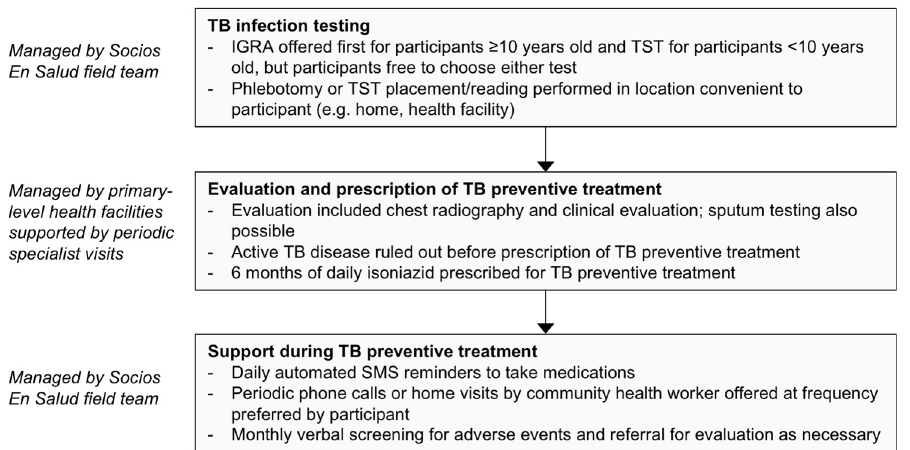
Fig 1. Key procedures for intervention participants. Abbreviations: TB = tuberculosis, IGRA = interferon gamma release assay, TST = tuberculin skin test.